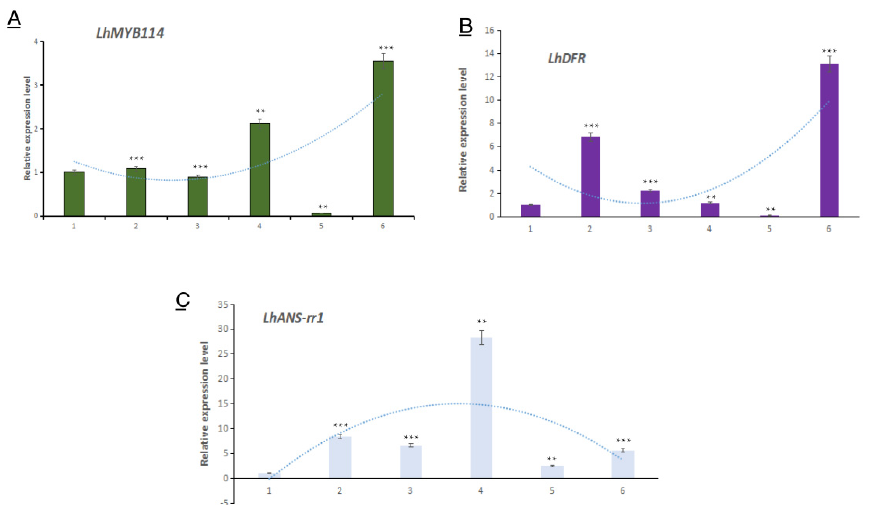
Figure 6. The qRT–PCR analysis of 3 key genes responsible for anthocyanin metabolism in flower buds of lily at different development stages. ( A ) The expression of LhMYB114 genes at different stages. ( B ) The expression of LhDFR genes at different stages. ( C ) The expression of LhANS-rr1 genes at different stages. The values are means ± SDs ( n = 6). The data were normalized to a value of 1 for the A group. Significant differences were determined by Student ′ s t test (** p < 0.01; *** p < 0.001).